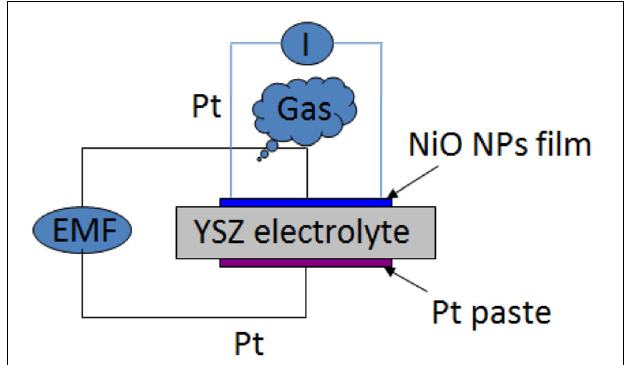
FIGURE 1 | The configuration of the developed bimodular planar high temperature gas